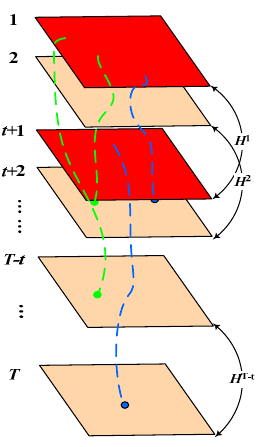
Figure 2. Illustration for the temporally partition of the input video.